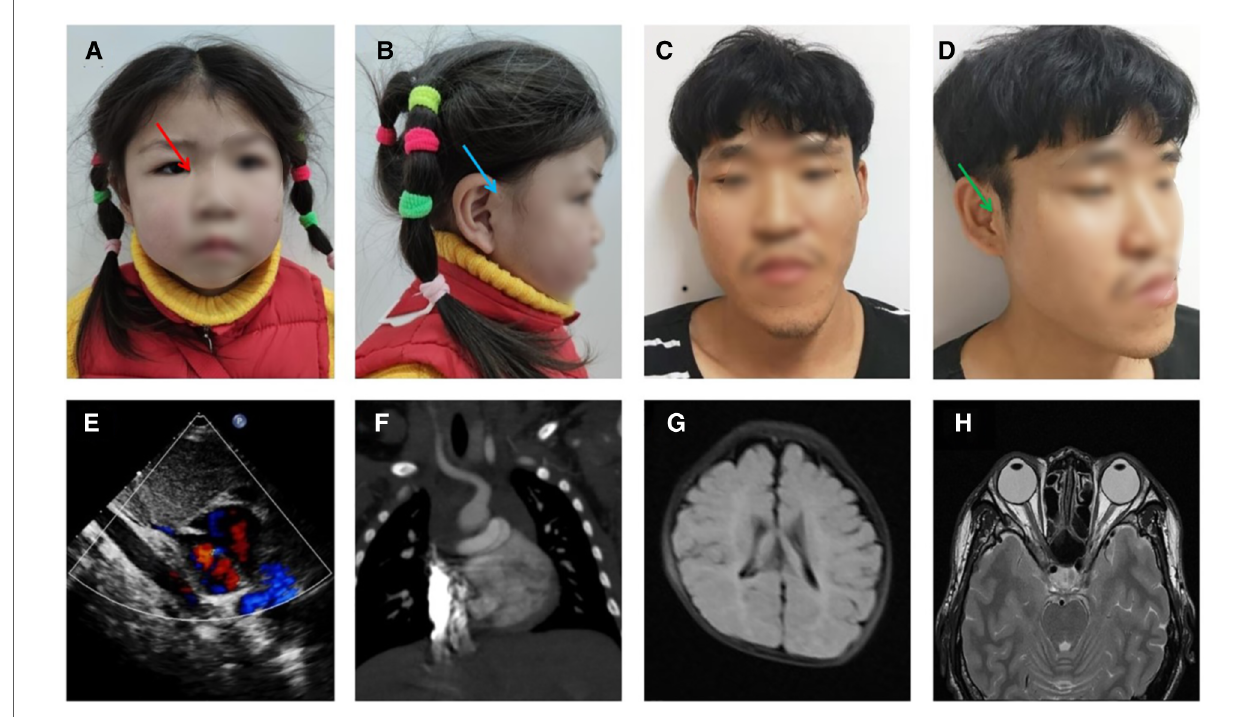
FIGURE 1 Craniofacial features and imaging results of the proband and father. ( A,B ) photograph of the proband at 4 years and 5 months: facial asymmetry, epicanthus (red arrow), and preauricular pits (blue arrow), ( C,D ) photograph of the father: facial asymmetry, epicanthus, and preauricular pits and kin tags (green arrow), ( E ) heart ultrasound of proband (1 M), ( F ) pulmonary artery CTA of the proband (4 M), ( G ) head MRI of the proband (4 M), ( H ) head MRI of the